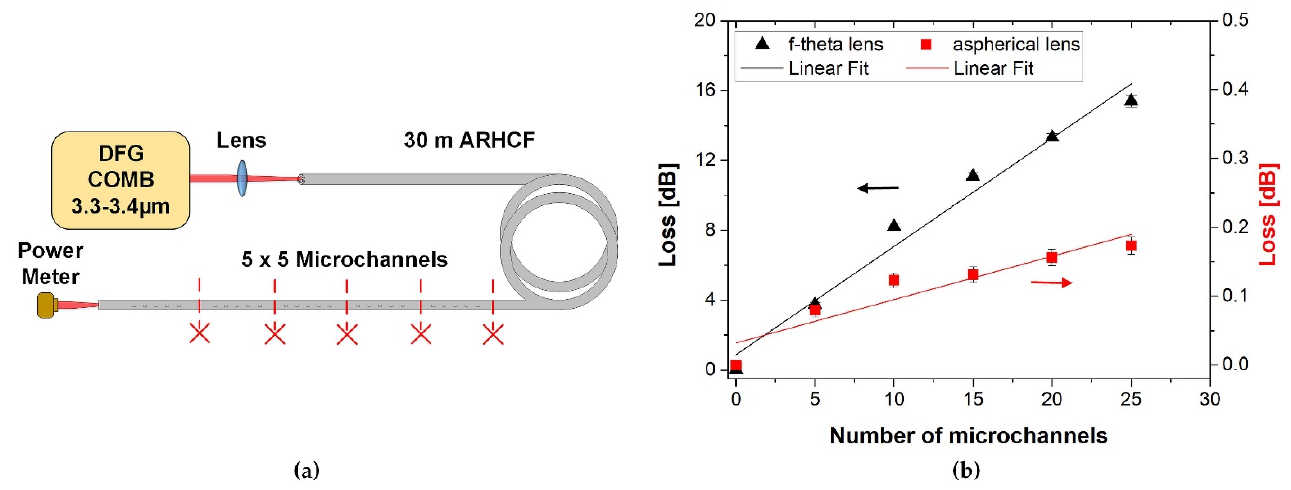
Figure 7. Influence of microchannel fabrication on transmission loss in the ARHCF for wavelengths 3.3–3.4 µm: ( a ) experimental setup and ( b ) loss measurement calculated as a function of the number of microchannels.